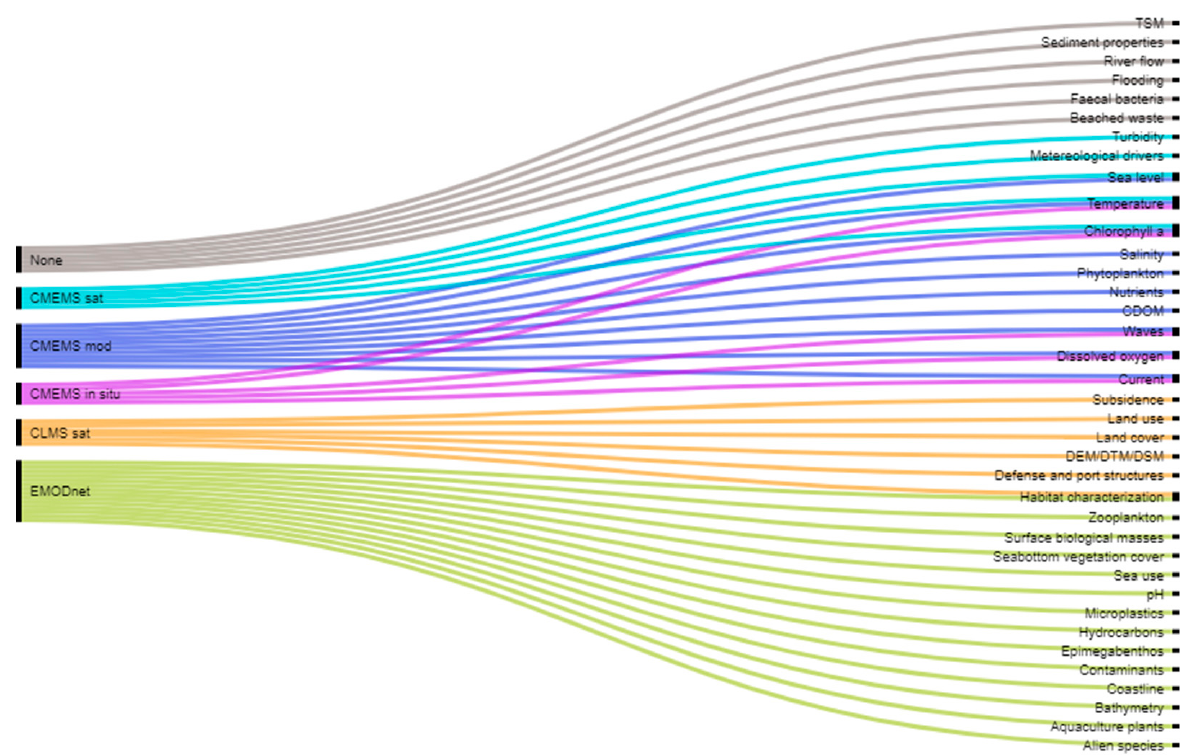
Figure 7. Parameters provided by Copernicus Core services and EMODnet.